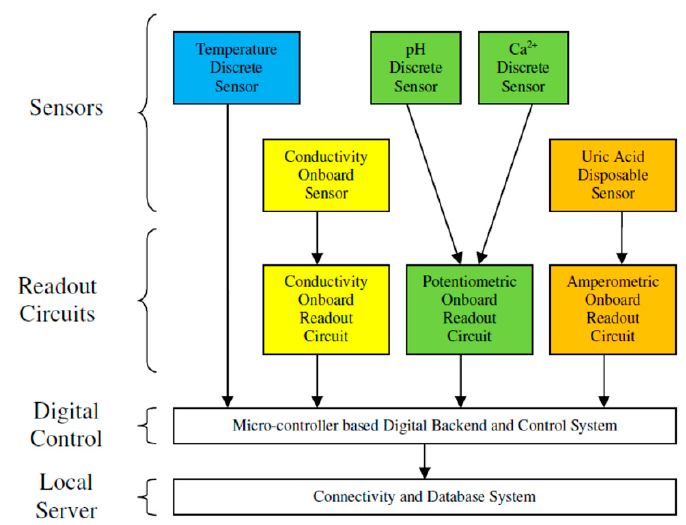
Figure 4. System block diagram.